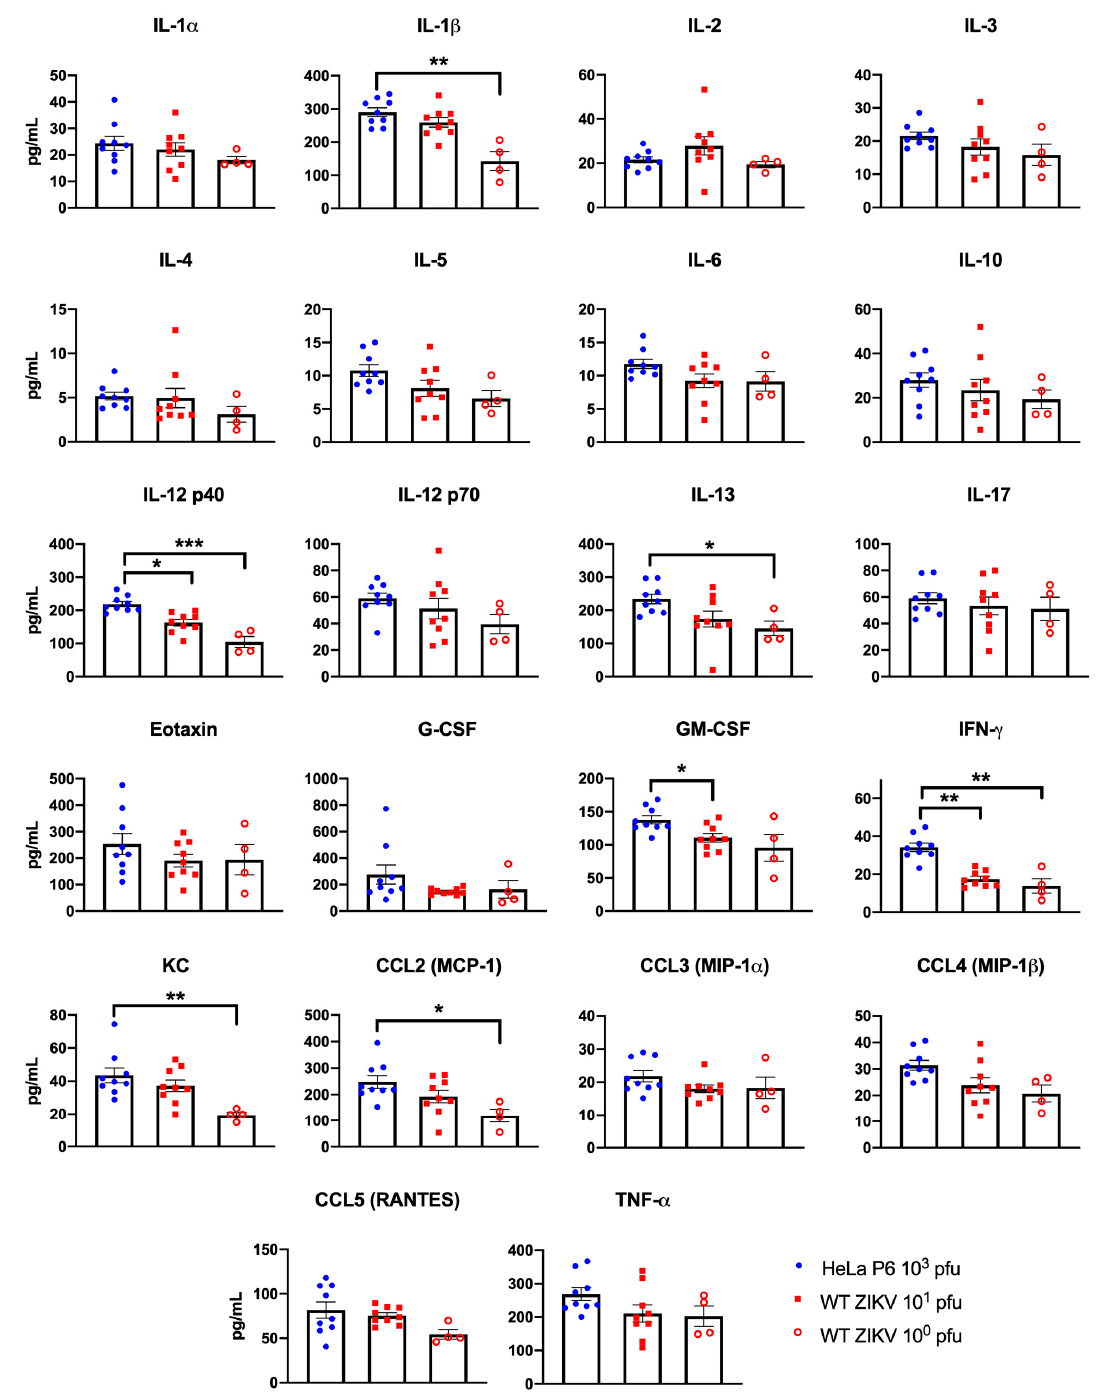
Figure 3. Passaging of ZIKV in HeLa cells increased circulating cytokines in AG129 mice. Mice were inoculated with WT ZIKV (10 0 or 10 1 pfu) or 10 3 pfu HeLa-P6, and the circulating cytokine response was measured at 3 days p.i. Cytokine and chemokine levels increased following infection with HeLa-P6 compared to WT ZIKV. WT ZIKV 10 0 pfu n = 4, WT ZIKV 10 1 pfu n = 9, Hela-P6 10 3 pfu n = 9. Kruskal–Wallis tests with Dunn’s multiple comparisons post-tests were used for statistical analysis. Bars represent the mean +/- standard error. * p < 0.05, ** p < 0.01, ** p < 0.001.